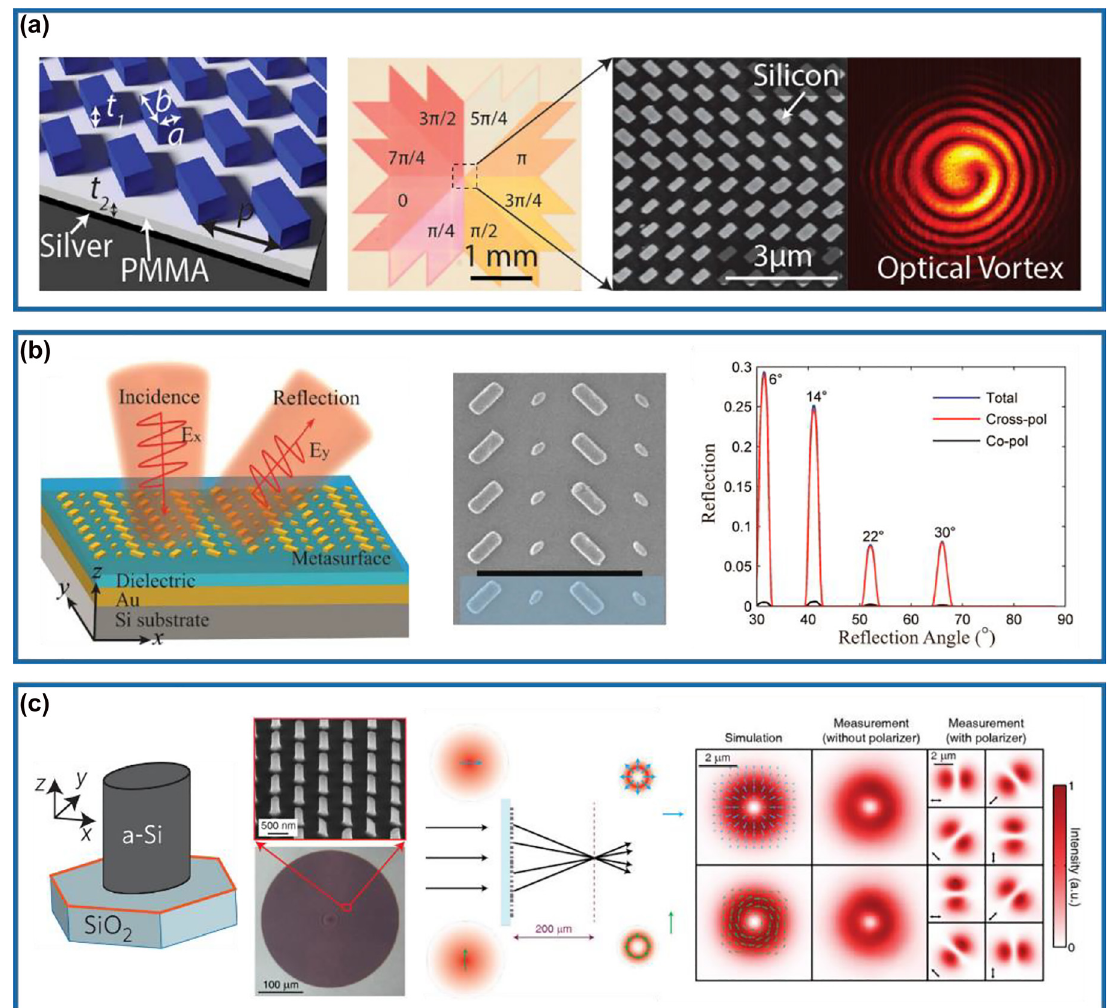
Figure2: Multifunctionalmeta-HWPsusingresonancephase.(a)Leftpanel:schematicofareflectivemeta-HWParrayconsistingofSibricks,a PMMA spacer, and an Ag reflector. Right panel: design and experimental demonstration of optical vortex beam generation in cross- polarization. Reprinted from Ref. [42]. (b) Left panel: schematic of the background-free plasmonic meta-HWP that enables polarization conversion and anomalous re fl ection in the cross-polarized channel. Middle panel: SEM image of the fabricated structure. Right panel: measurednormalizedre fl ectionofthefabricatedsampleasafunctionofincidentangleunder x -polarizedexcitationat λ =1000nm.Reprinted from Ref. [73]. (c) Left panel: schematic, SEM, and optical microscope images of the elliptical Si posts on top of a SiO 2 substrate. Right panel: illustration and demonstration of focused radially (azimuthally) polarized Bessel – Gauss beam generation under the excitation of an x -polarized ( y -polarized) Gaussian beam. Reprinted from Ref.